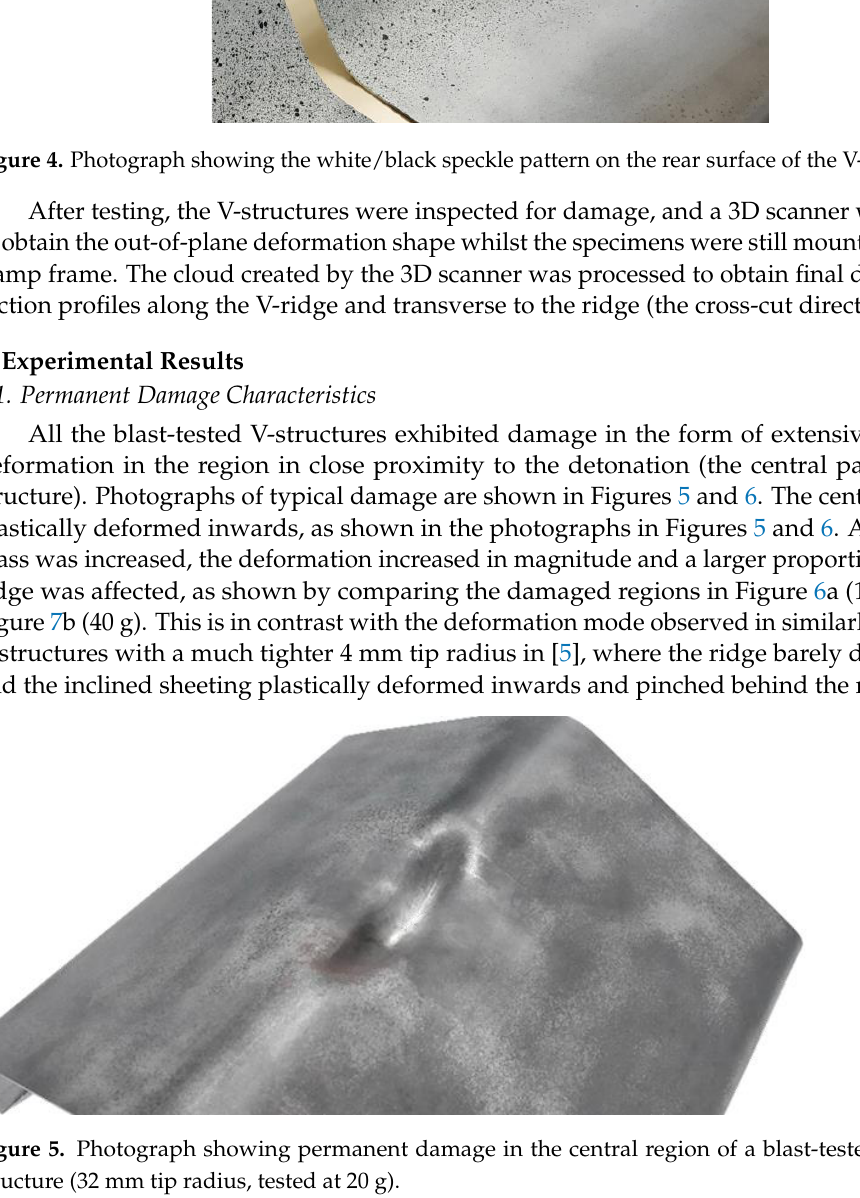
( b ) Figure 6. Photographs showing the top view a blast-tested 105° V-structure, 32 mm tip radius, with localised permanent deformation along the central ridge: ( a ) tested at 10 g, ( b ) tested at 40 g. ( a )